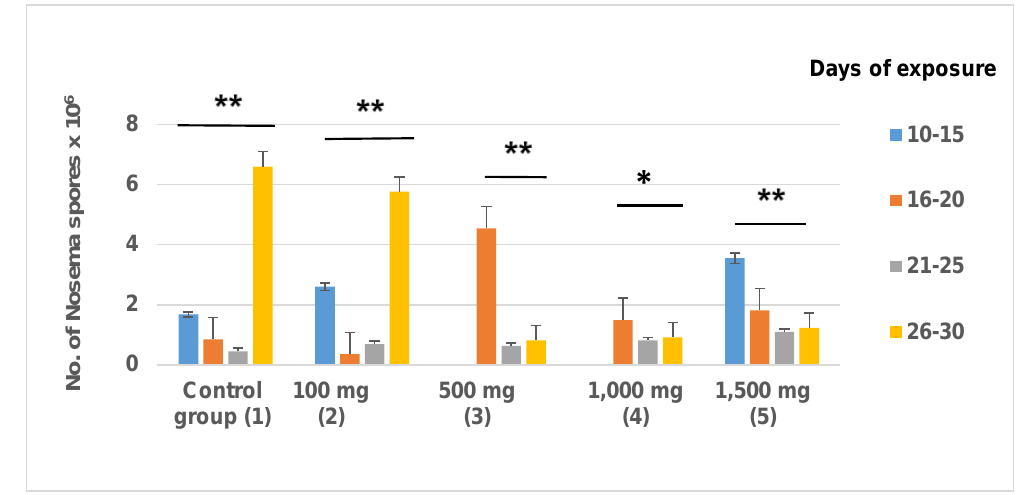
Figure 3. The number of Nosema ceranae spores counted in dissected bees. The average values are expressed in millions of spores per worker bee. HMF quantity is expressed as mg/kg of HMF in Apifonda candy. The control group received only Apifonda candy. Asterisks indicate a statistically significant difference of N. ceranae spore counts inside a treatment group on different sampling dates.